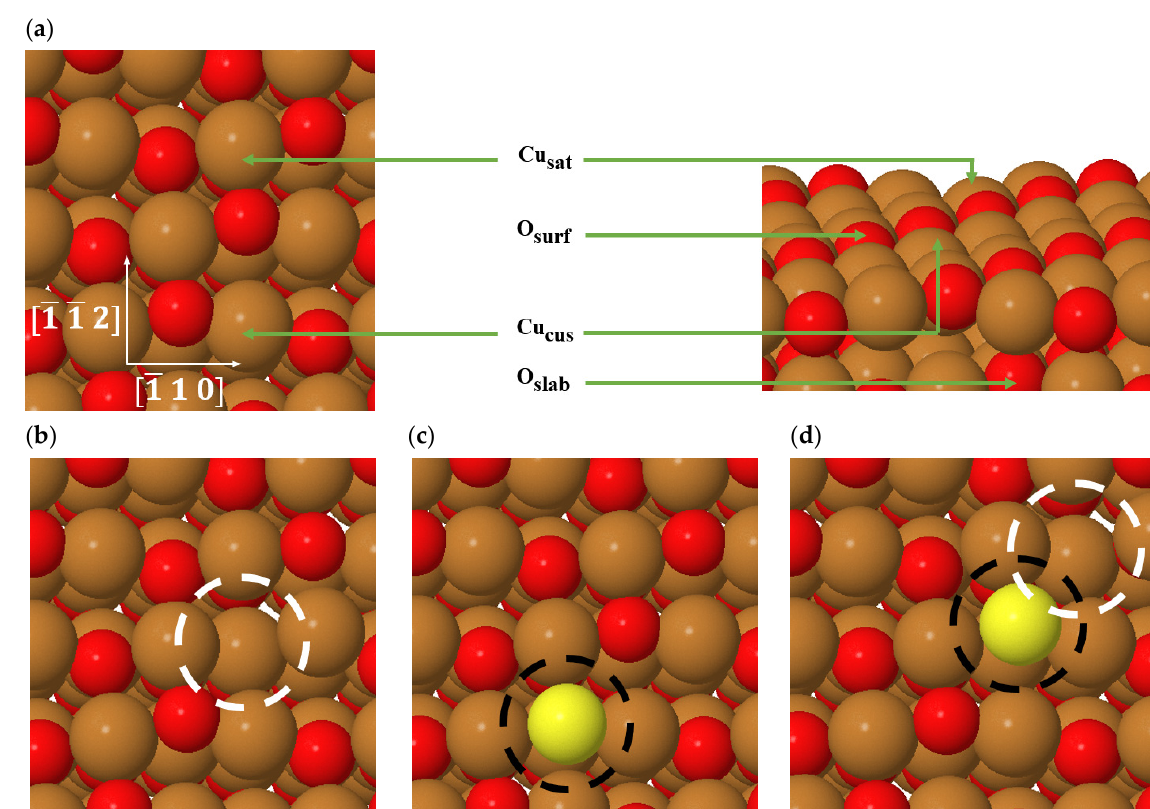
Figure 5. Top and side views of the ( a ) CuO(111) surface. The cus and sat on CuO(111) represent a coordinatively unsaturated site and saturated site, respectively. The vertical and horizontal arrows on the CuO(111) surface in (a) represent the [ 𝟏(cid:3365)𝟏(cid:3365) 2] and [ 𝟏(cid:3365) 10] crystallographic directions. ( b – d ) The top views of O vacancy, surface S atom, and both O vacancy and surface S atom employed on CuO(111) surfaces, respectively. Each O vacancy (white) and surface S atom (black) are indicated by a dashed circle.